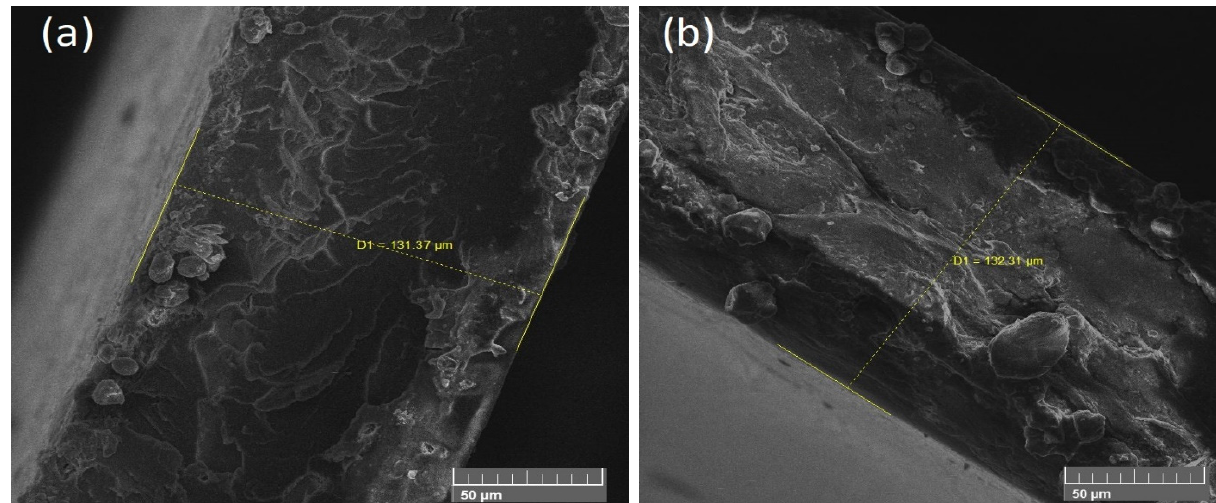
Figure 4. SEM Images of ( a ) S1, ( b ) S2, and ( c ) S4.